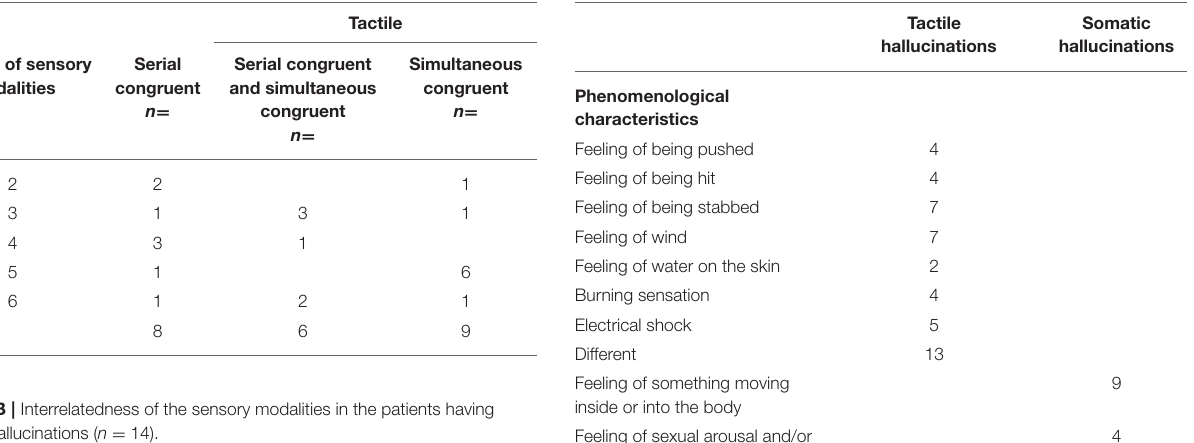
TABLE 3A | Interrelatedness of the sensory modalities in the patients having tactile hallucinations ( n = 23).